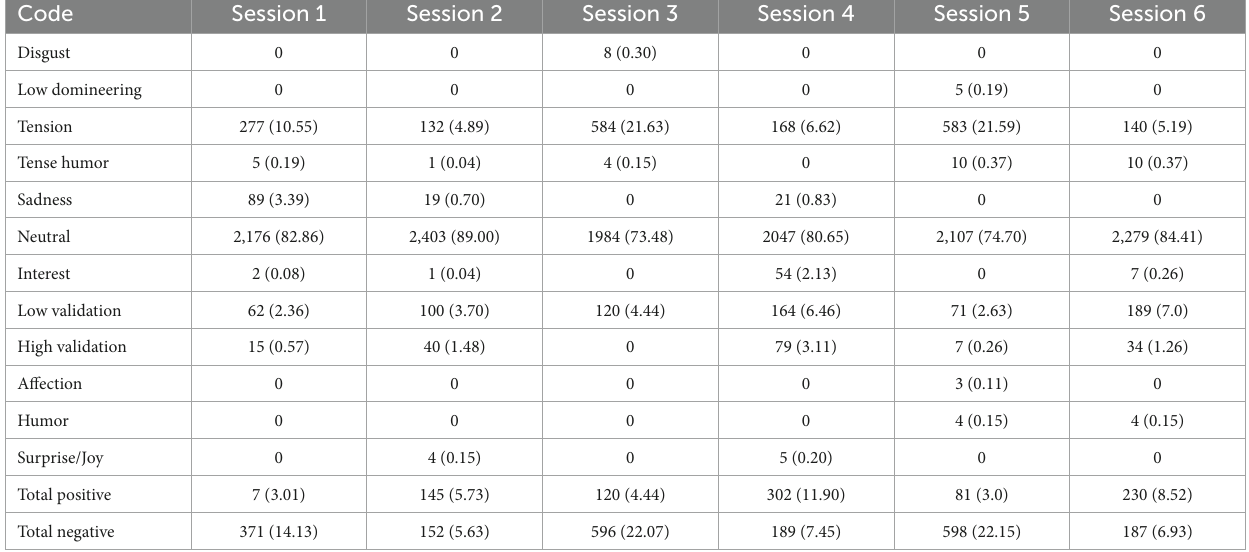
TABLE 2 SPAFF codes for Aimee over six sessions.